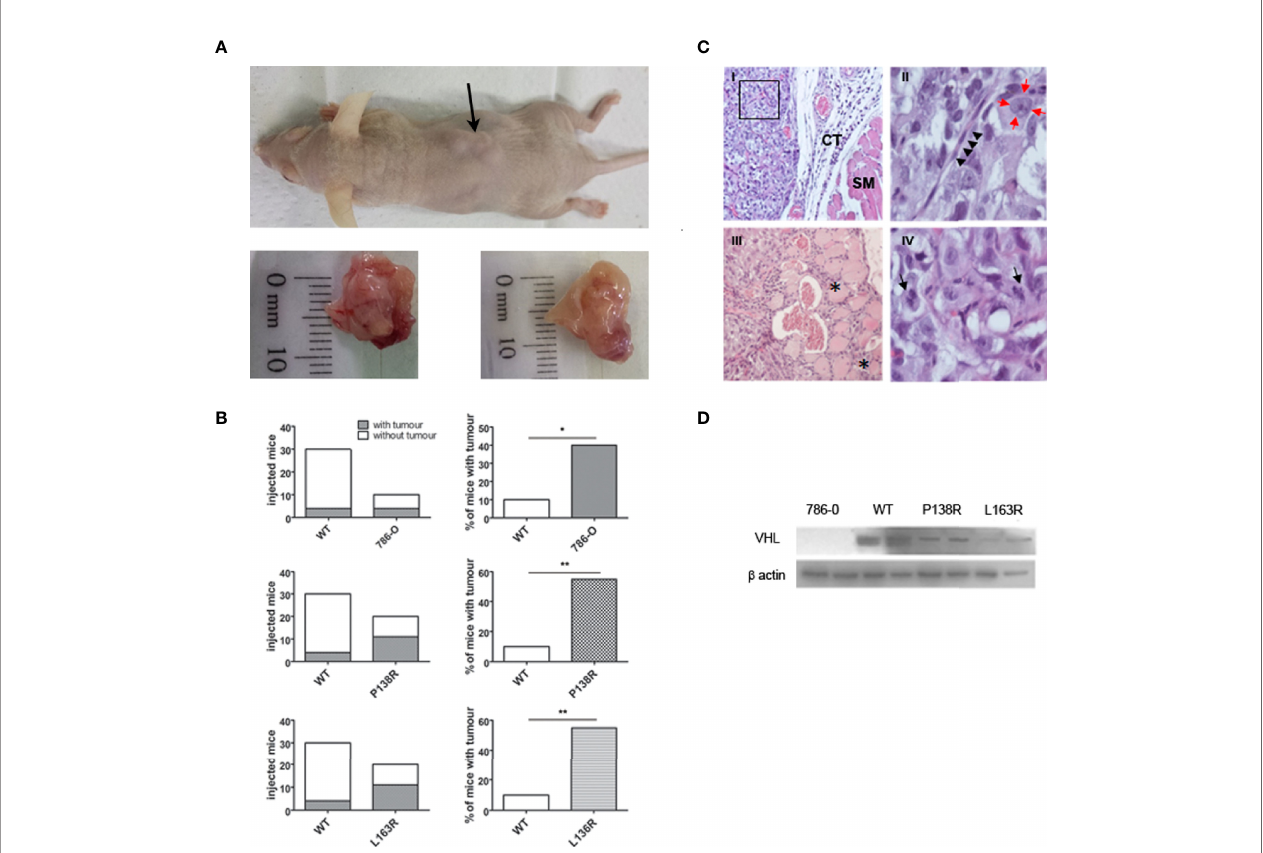
FIGURE 4 | In vivo studies showed tumor development for P138R and L163R pVHL variants. (A) Representative picture of nude mice and the tumors developed. The arrow points toward a tumor (upper panel). The bottom panel shows the macroscopical aspect of the tumors. (B) Left plots represent the incidence obtained for each cell line when injected on immunode fi cient mice, and percentages are plotted on the right panels. ns, not signi fi cant; *p = 0.0306, **p = 0.0005, two-tailed chi- square test. (C) Histological features of the experimentally obtained tumors and stained with H&E. Panel I, Tumor cells distributed as lobes of polyhedral cells separated by fi ne fi bers of connective tissue (CT) and striated muscle (SM) ×20 (Panel I). Panel II, a magni fi cation of a sector of panel I shows a connective septum with central endothelial nuclei corresponding to the capillary vessel (marked with black arrowheads), surrounded by tumor cells with nuclei (red arrows) with prominent central nucleolus; ×100. Panel III presented tumor in fi ltrating the neighboring striated muscle, and the asterisks (*) indicate traces of tumor progression between the muscle bundles. Panel IV shows mitotic fi gures indicated with black arrows; ×100. (D) Representative Western blot showing the expression of VHL protein in the tumors developed by 786-O, WT, P138R, and L163R cell lines. b -Actin was blotted as loading